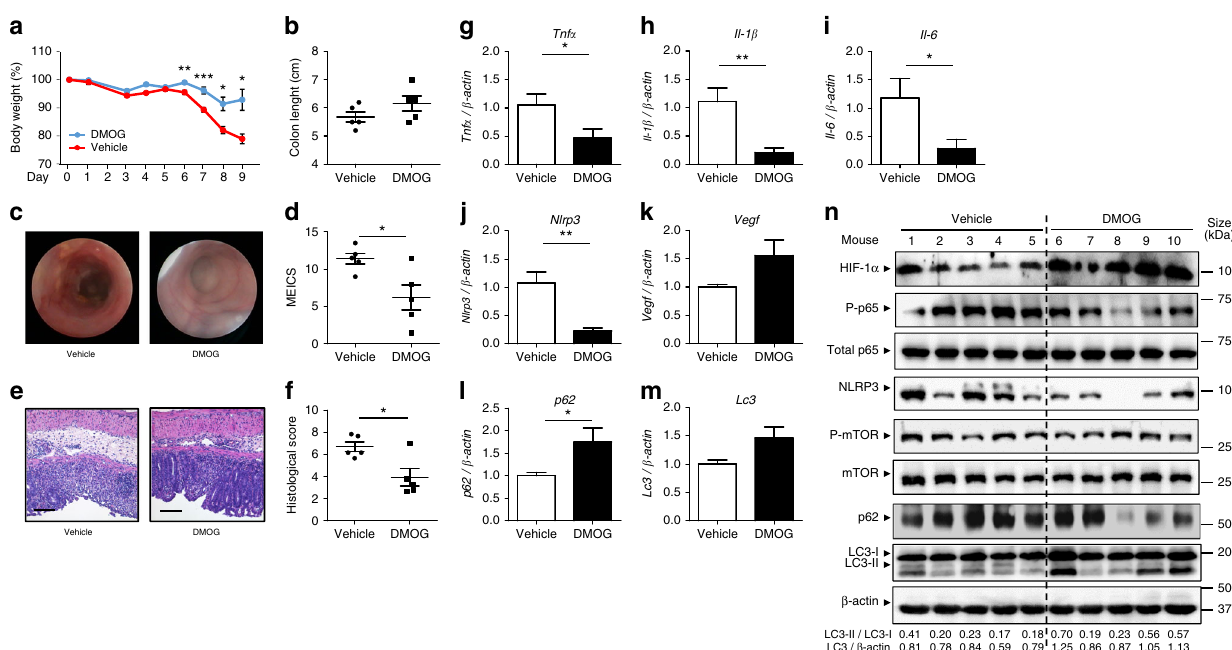
Fig. 7 DMOG reduces in fl ammation and induces autophagy in DSS-treated mice. a , b , c , d , e and f WT mice were administered with 2% DSS for 5 days and co-administered with 8 mg DMOG injected intraperitoneally every second day. Weight loss was monitored during the course of treatment a . After a recovery period, mice were killed at day 9 colon biopsies were collected and colon length was measured b . Mucosal damage was assessed by colonoscopy c and murine endoscopic score of colitis severity ( MEICS ) was calculated d . H&E staining of distal colon sections displayed a signi fi cant decrease in barrier breakdown and in fl ammatory in fi ltrate in DMOG-treated mice e . Scale bar, 100 µ m. Total histological score at day 9 was calculated as the sum of epithelial damage and in fi ltration score f . g , h , i , j , k , l and m distal colon biopsies were collected and transcript analysis was performed. Statistical analysis was performed using Student t- test.Results represent mean + s.e.m., DSS-treated mice administered with PBS: n = 5; DSS-treated mice administered with DMOG: n = 5; * P < 0.05; ** P < 0.01. n Total protein was isolated and Western blot performed. LC3-I and LC3-II bands were quanti fi ed, and autophagy was measured by variations in the ratio of LC3-II/LC3-I and the total amount of LC3 (LC3-I plus LC3-II) relative to β